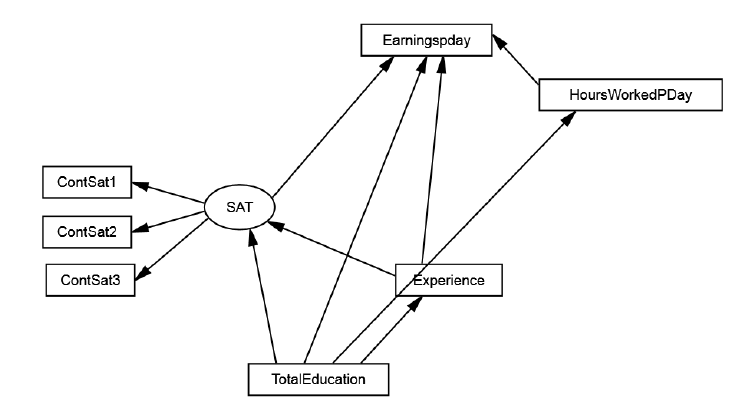
FIGURE 1: The tested model of human capital mediation relationships